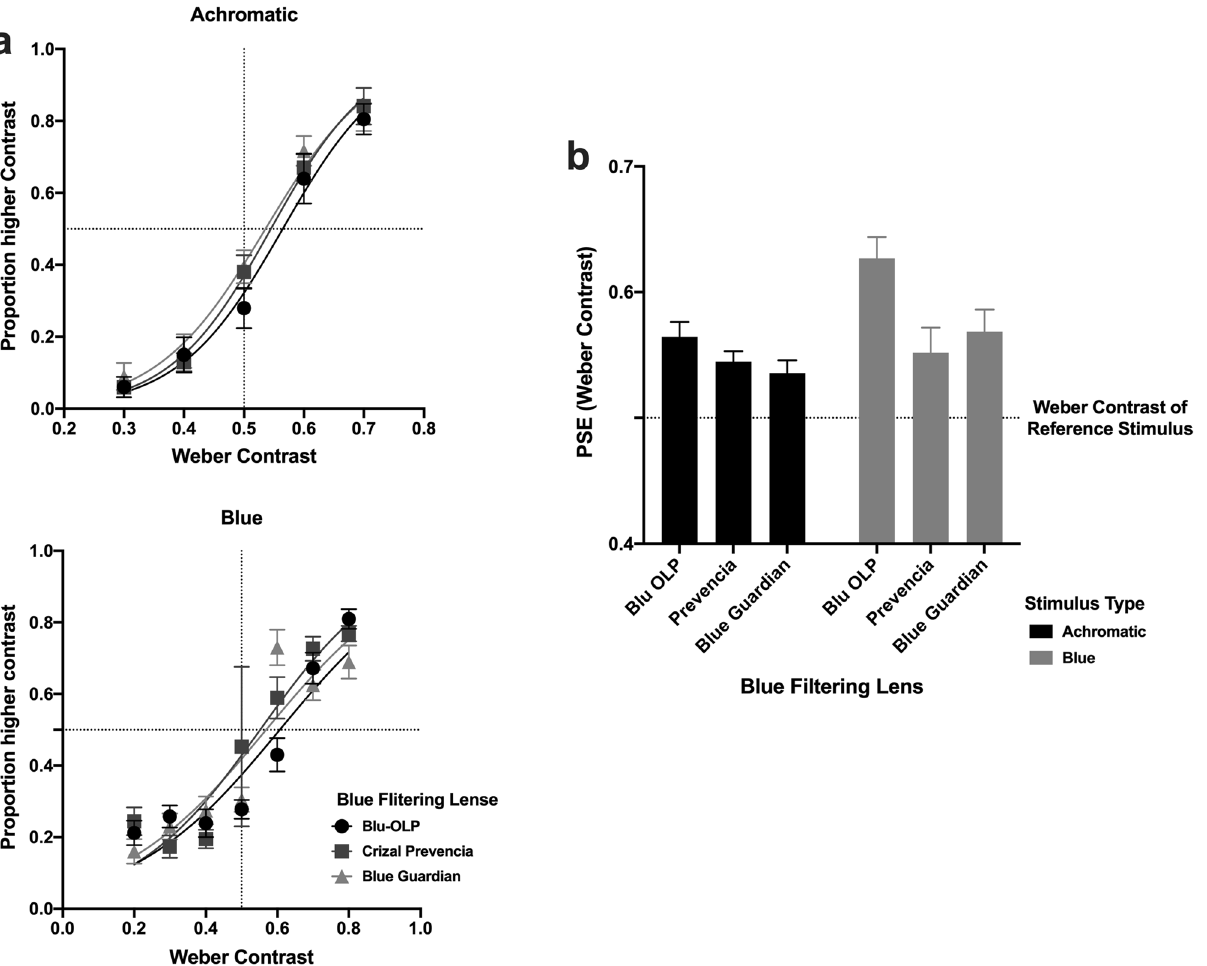
Figure 5. The proportion of times in which the test stimulus was judged to be higher in contrast than the reference stimulus is plotted as a function of the test stimulus contrast in ( a ). In ( b ), the PSE of the best fit psychometric function is plotted for each BFL and stimulus colour. Error bars represent 1 standard error of the